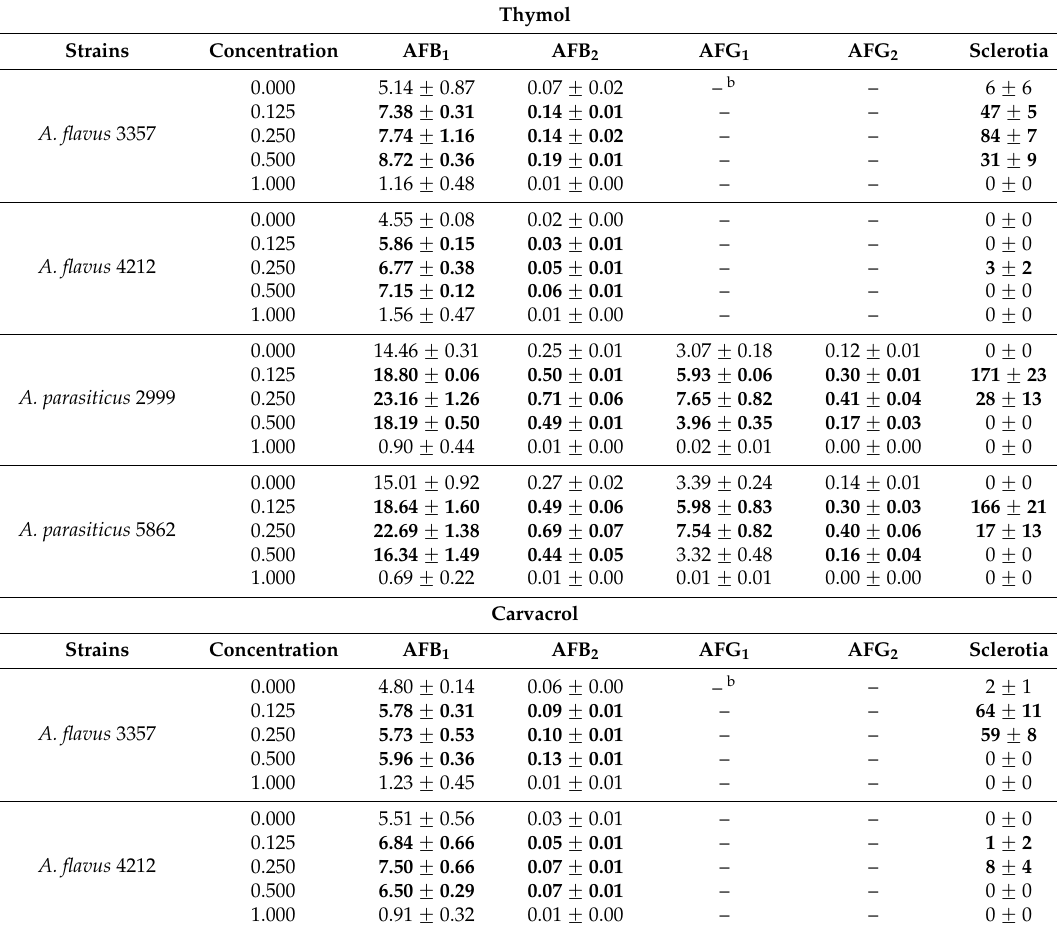
Table 6. Effect of 2H4M and monoterpenoid phenols on the production of aflatoxins and sclerotia. Increased values compared to no treatment control are in bold characters. a Thymol